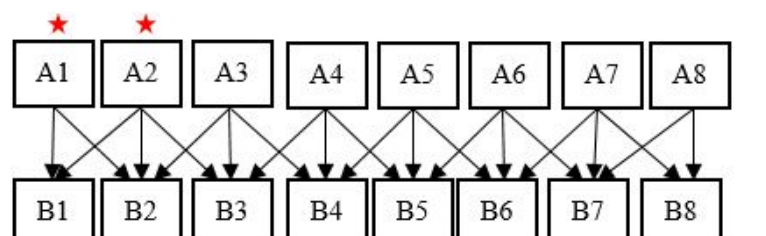
Figure 3. New individuals after CECGA (Red stars are preserved parents, green is the current op- timal solution). 4.2. Proposed Routing Based K-Medoids Clustering Our K-medoids-based clustering (KMC) algorithm reduces energy consumption and extends the network lifetime. Cluster head nodes collect data from all nodes via a base station in our proposed scheme. This is followed by a calculation of K of the cluster num- ber. The iteration time is reduced by computing the central circle mean points and remain- ing energy. Here are the steps of the algorithm: Step 1: Sensor nodes are distributed into clusters, and the cluster head nodes are lo- cated during the first phase. The number of clusters is calculated during this phase, and the cluster head nodes are selected. Initialize greedy select K of the N-data points as me- doids to minimize the cost. Equation (14) can be used to calculate K , the number of clus-